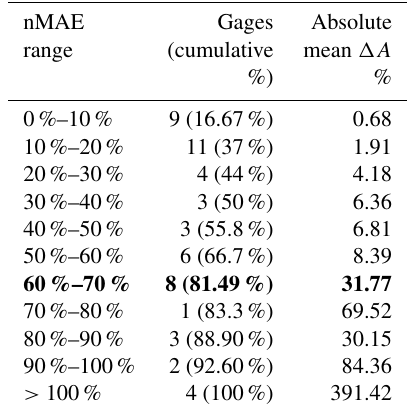
Table 4. Absolute mean (cid:49)A gage count and grouped by nMAE between NWIS and NWM streamflow. The bold row highlights a distinct break in the data. Once the normalized mean average error in the NWM forecasts exceeds 60%, the accuracy in flood maps decreases substantially.